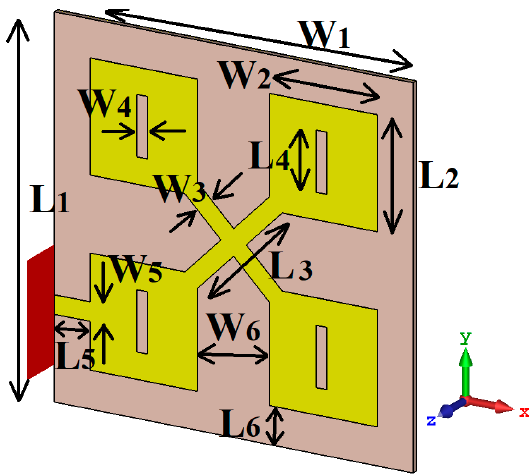
Figure 3. Configuration of the proposed microstrip antenna array with a ground-plane. Table 1. Antenna structural parameters.